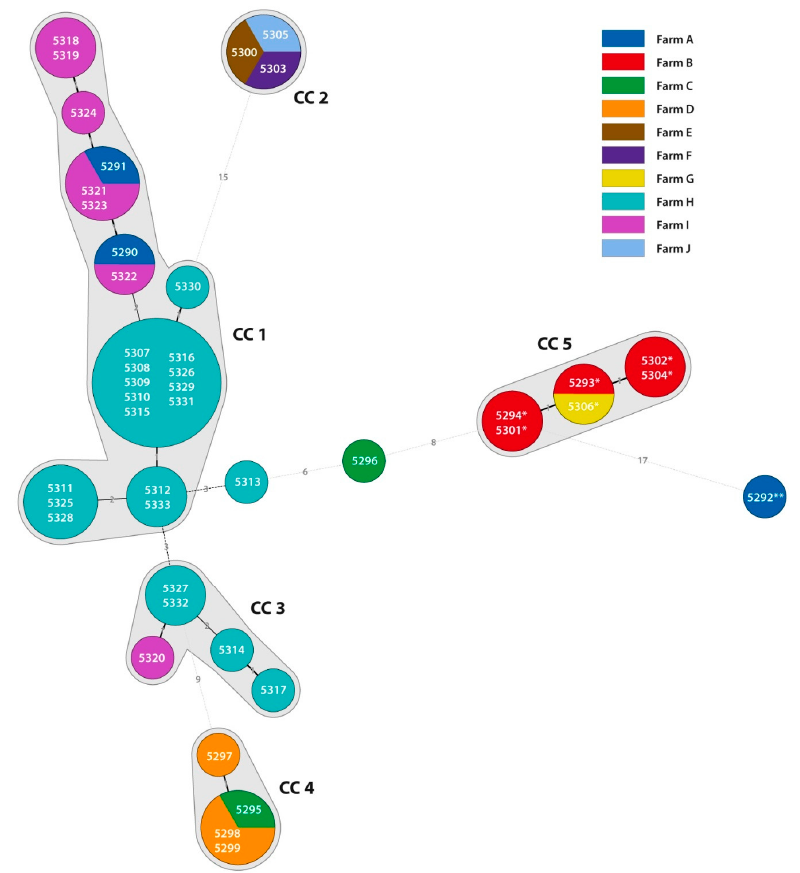
Figure 2. Minimum spanning tree of Clostridioides ( Clostridium ) difficile isolates in the study. The numbers in the circles represent DNA number of C. difficile isolate. The numbers on the lines represent the sum of tandem repeat differences (STRD) between isolates. If more than one number is present in one circle, it represents isolates with STRD = 0. A clonal complex (CC) was defined as the sum of tandem repeat differences (STRD) ≤ 2. * The clonal complex 5 consists of C. difficile isolates ribotype 126; **The C. difficile isolate no. 5292 belongs to the ribotype 046. All isolates were sensitive to amoxicillin, metronidazole and vancomycin. Ten C. difficile isolates (22.7%) were multidrug resistant. Forty isolates (90.9%) were resistant to ciprofloxacin, twenty-one